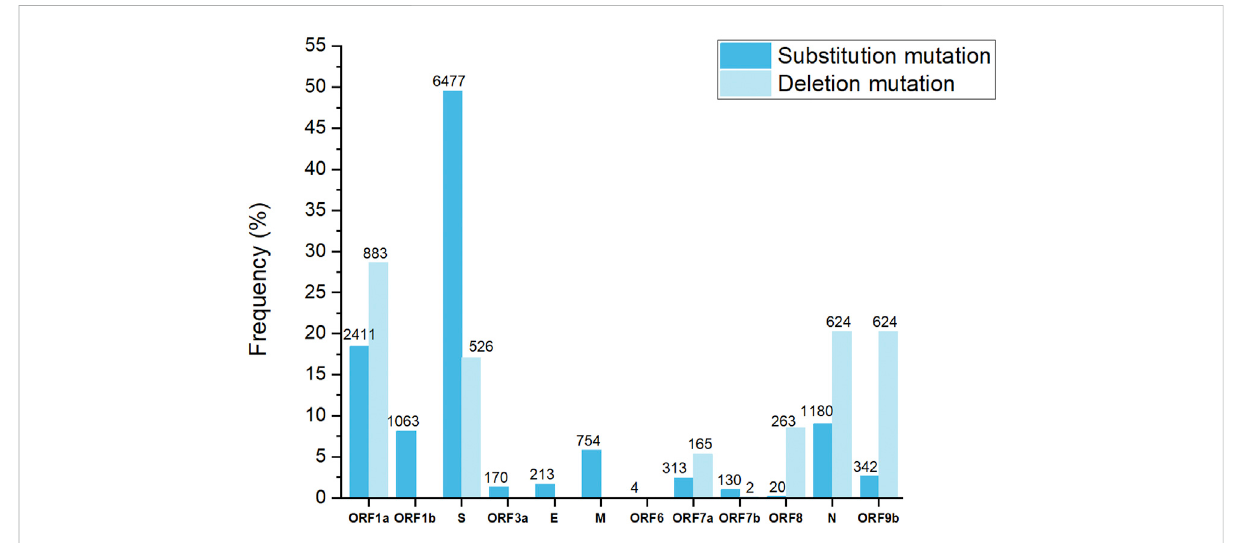
FIGURE 3 Substitution and deletion mutation frequency in sequenced SARS-CoV-2 genomes. The numbers indicate the number of